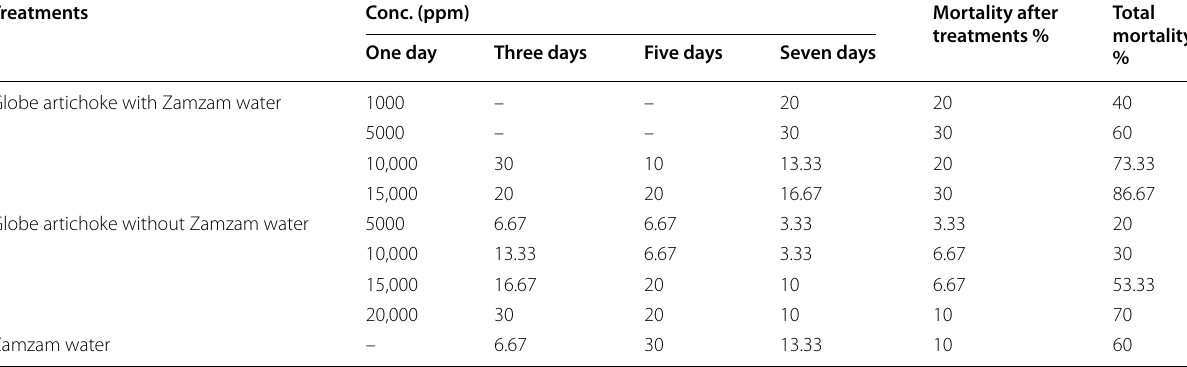
Table 1 Corrected mortality % of P. solenopsis treated with Zamzam water, globe artichoke extract with and without Zamzam water under laboratory conditions Treatments Conc. (ppm)